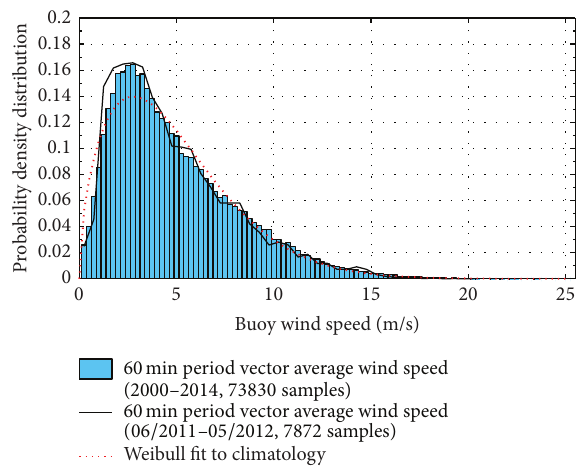
Figure 2: Histogram of the wind speed climatology computed using in situ hourly observations acquired by the “ODAS Italia 1” buoy in theperiodJanuary2000–March2014.SuperimposedaretheWeibull fit (dotted line) to the climatology and the histogram (solid line) of the in situ wind speed observations used in the study.